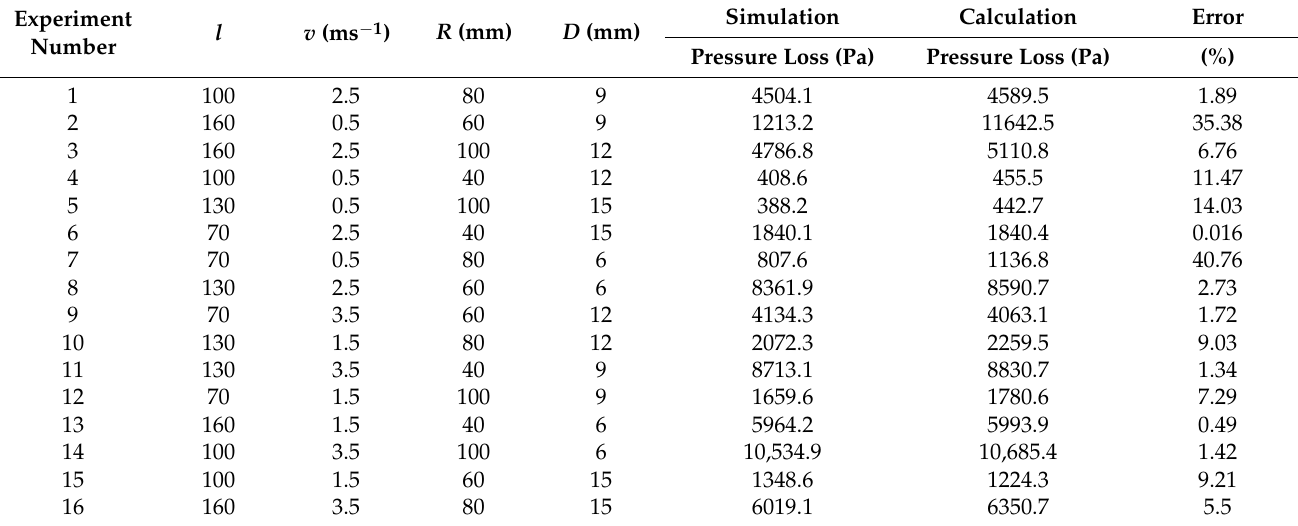
Table 6. Orthogonal experimental simulation results and mathematical model calculation results.